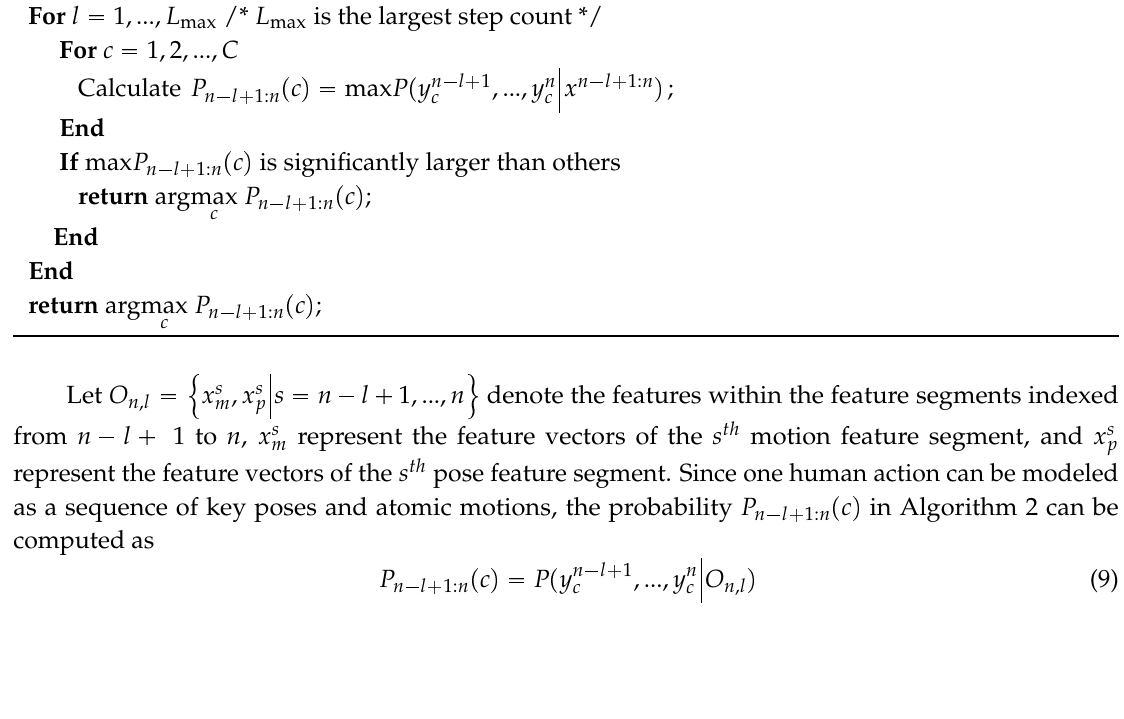
Figure 5. Maximum Entropy Markov Model. Algorithm 2. The variable-length MEMM process